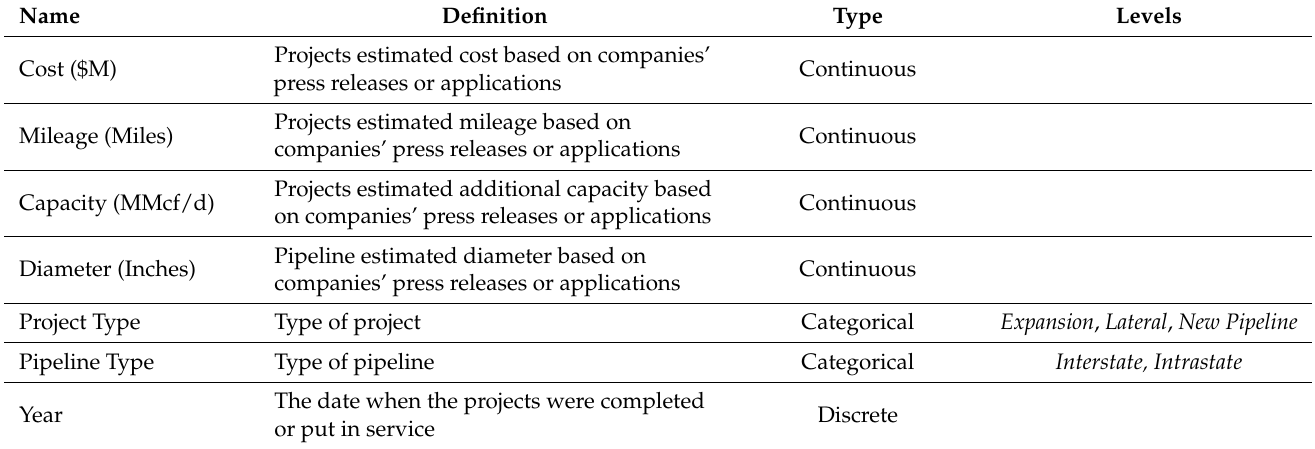
Table 3. Variables of the dataset.